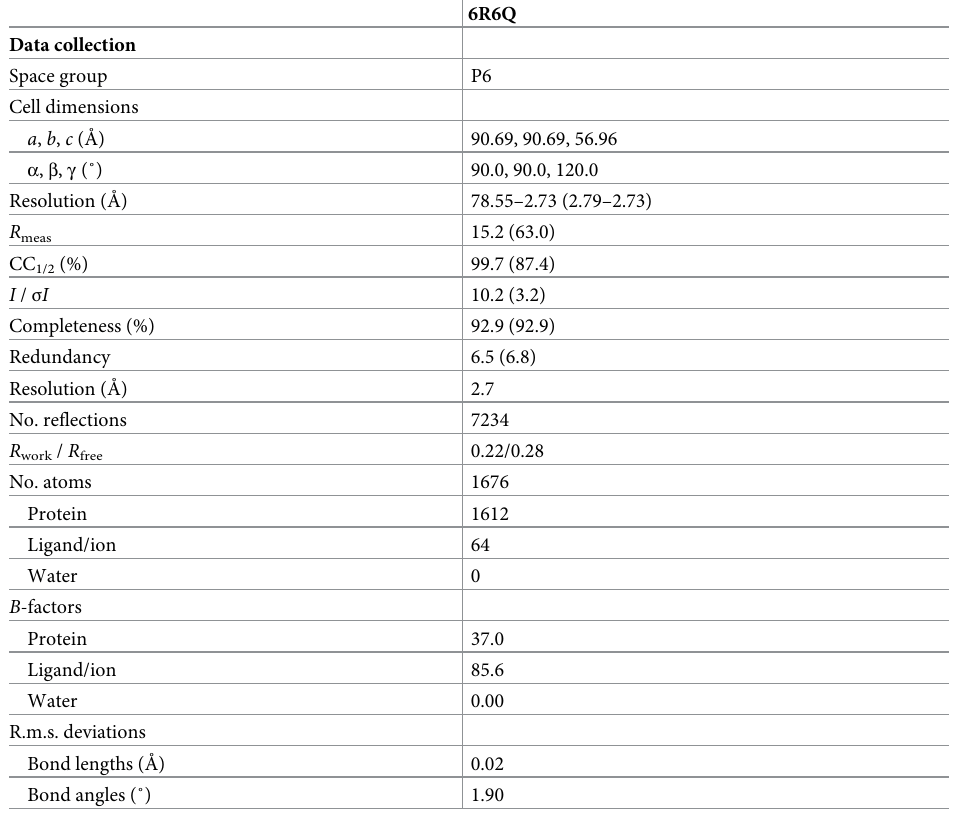
Table 1. Data collection and refinement statistics. The CA-IP5 hexamer complex was deposited in the PDB with code 6R6Q. Statistics for both data integration and model refinement are